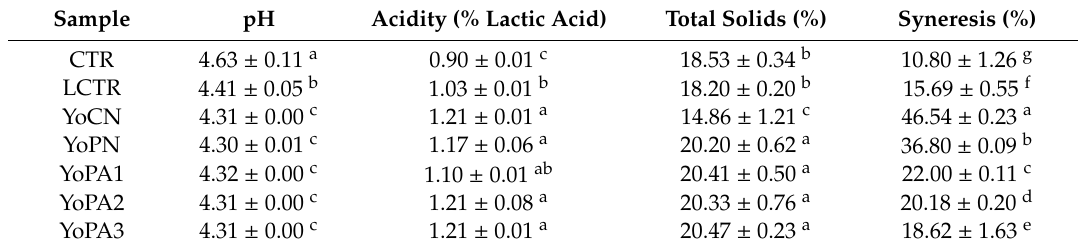
Table 3. Physicochemical properties of yoghurt stabilized with acetylated pigeon pea